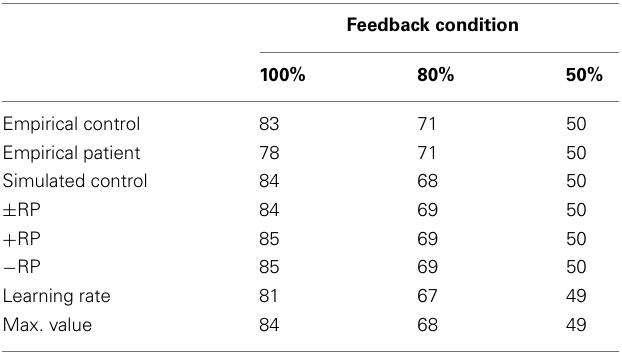
Table 3 | Empirical and simulated accuracy rates for control subjects and schizophrenia patients on the probabilistic learning task.